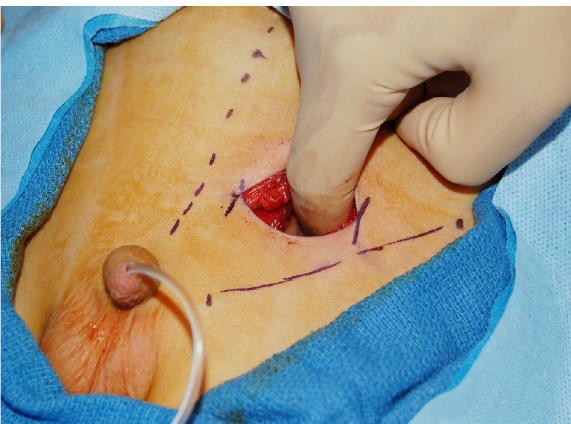
Figure 1 - Intraoperative example of inguinal